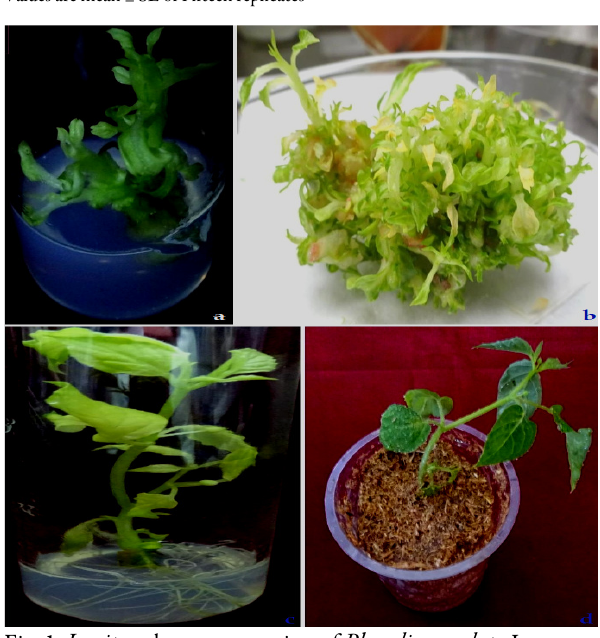
Fig. 1. In vitro plant regeneration of Physalis angulata